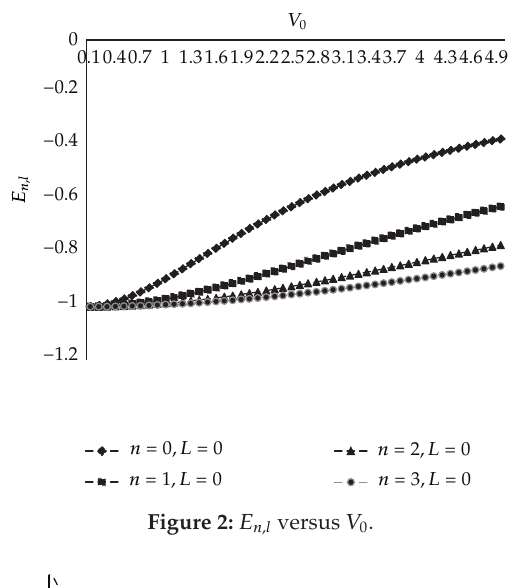
Figure 2: E n,l versus V 0 .